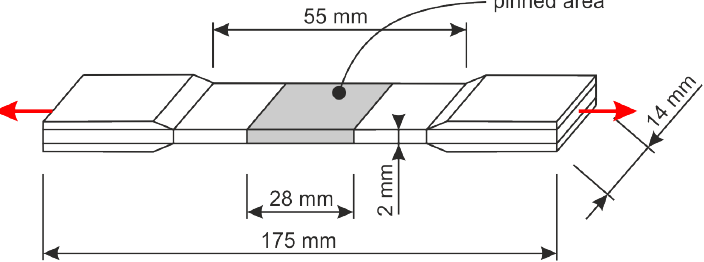
Figure 2. Specimen geometry, position of pinned region as well as test set-up for the determination of the tensile properties of unpinned and z-pinned UD carbon-fiber reinforced composite